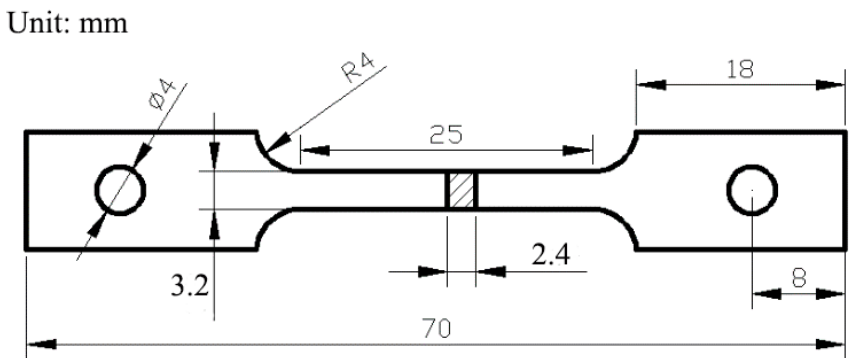
Figure 1. Shape and dimensions of the SSRT samples.